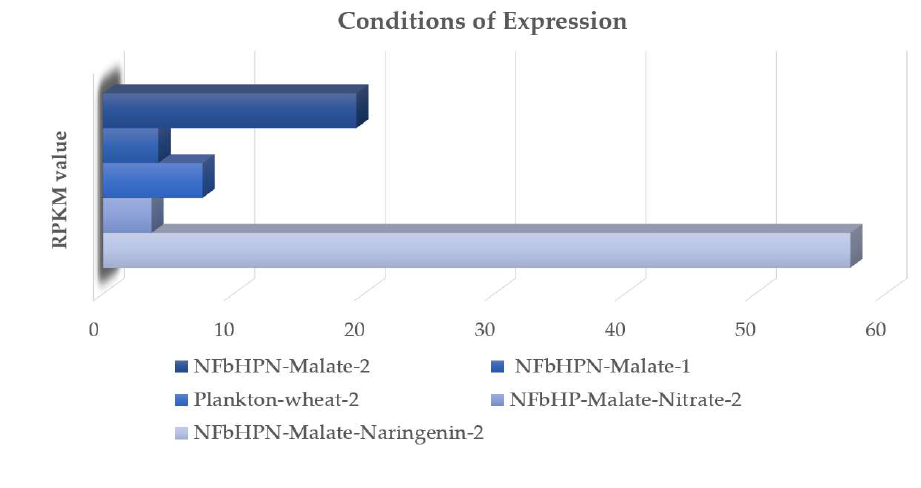
Figure 2. Visualization of position and expression profile of 5_ureB_sRNA ncRNA in the genome of H. seropedicae SmR1. The sequence was located using the Artemis program. The readings delineated within the pink rectangle refer to: ( a ) Levels of expression of 5_ureB_sRNA ncRNA in RNA-seq assays in H. seropedicae SmR1. In color, the analyzed experimental conditions represented are shown, where 1 and 2 represent d.a.i (days after inoculation); ( b ) the numbers represent the value of the gene expression in reads per kilobase of transcript per million mapped reads (RPKM).